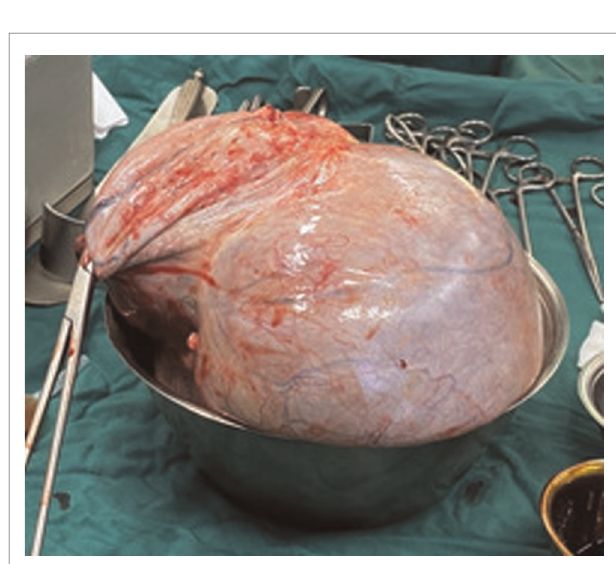
FIGURE 3 | Completely removed the giant ovarian